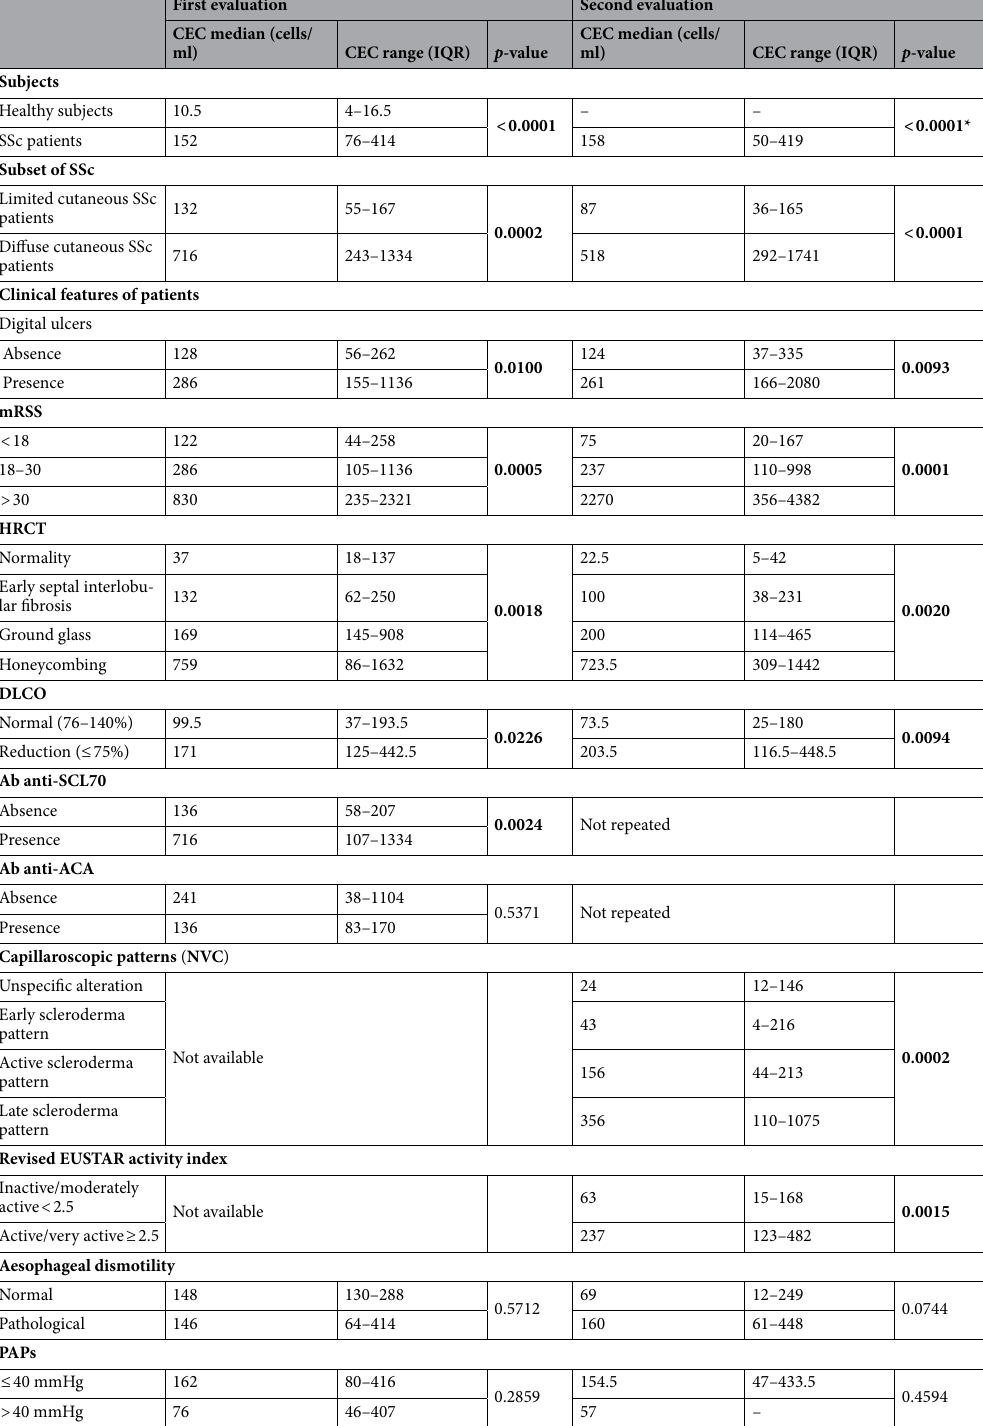
Table 1. Quantification of CECs/ml in controls and patients and association between the two subsets of disease and the clinical features. Median CEC value/ml in peripheral blood, interquartile range (IQR) of values and overall p -value during first and second evaluation. The association between CECs, revised EUSTAR activity index and NVC were calculated only during the second clinical evaluation of patients. Data highlighted in bold indicate statistically significant association. *Comparison with values of healthy subjects at first